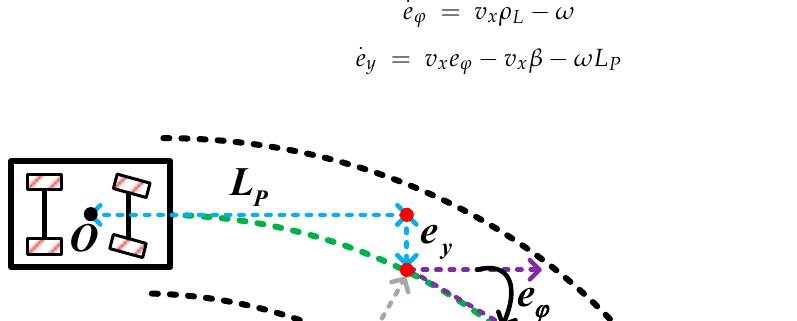
Figure 3. 2DOF vehicle dynamic model.